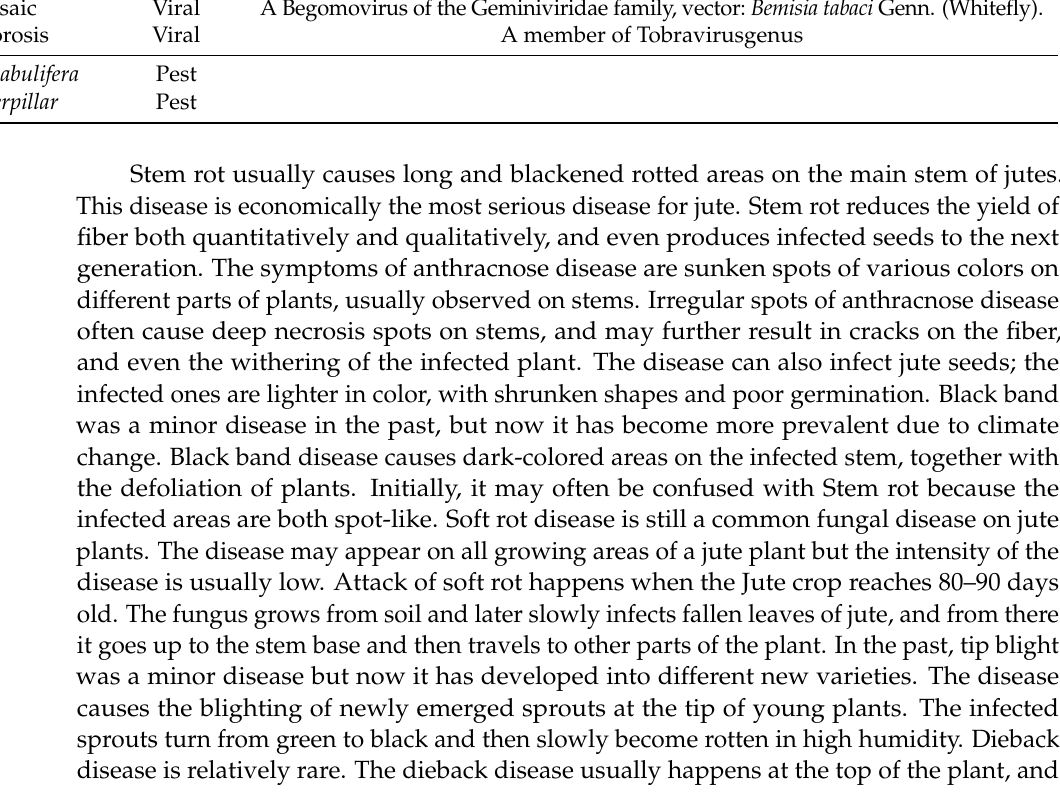
Fungal Diplodia corchori Syd. and P.